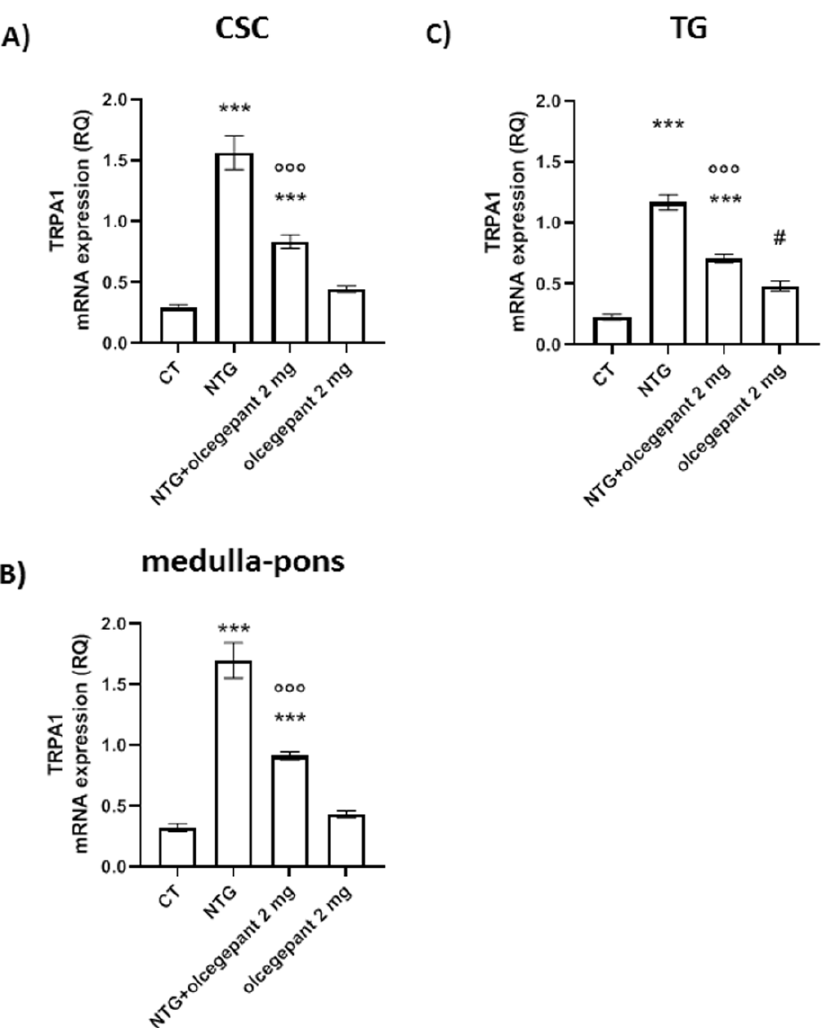
Figure 8. TRPA1 gene expression levels in ( A ) cervical spinal cord (CSC), ( B ) medulla–pons, and ( C ) trigeminal ganglion (TG). mRNA levels are expressed as relative quantification (RQ). Data are ex- pressed as mean ± SEM; one-way ANOVA followed by Tukey’s multiple comparisons test. *** p < 0.001 vs. control (CT) and olcegepant 2 mg; °°° p < 0.001 vs. nitroglycerin (NTG); # p < 0.05 vs. CT.